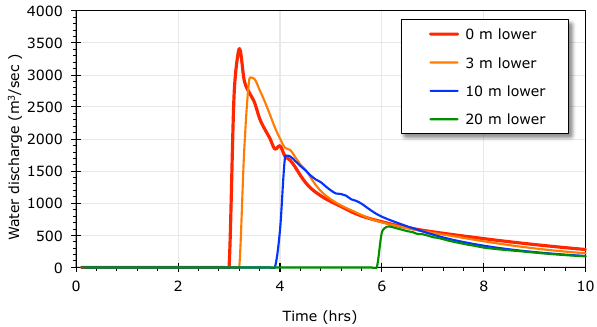
Figure 8. GLOF hydrographs at Dingboche under current lake conditions for 0 m, 3 m, 10 m and 3